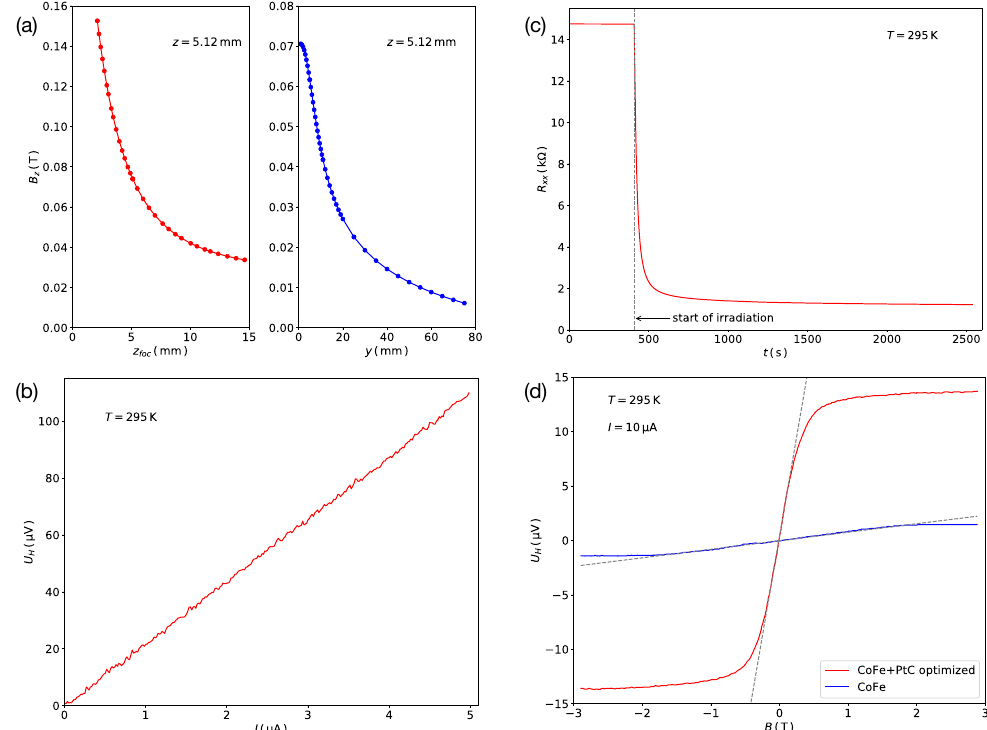
Figure 4. ( a ) Dependence of magnetic induction perpendicular to sample surface at a fixed working distance of 5.12mm vs. change of focal length of immersion lens (left). Dependence of the magnetic induction for lateral movement at fixed working distance, as indicated, and for fixed focal length (right). ( b ) In situ measured Hall voltage of Co-Fe/Pt GFM Hall cross vs. current. Data taken at room temperature. ( c ) Change of longitudinal resistance R xx vs. time during post-growth electron irradiation of GFM sample at 1.6nA and 5keV. ( d ) Comparison of Hall voltage vs. magnetic field measured ex situ for optimized GFM Hall sensor and pure Co-Fe deposit at temperature and current as